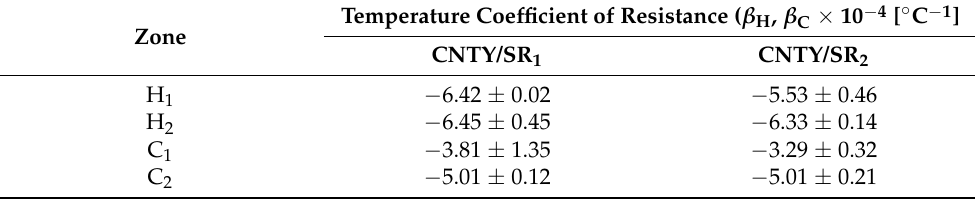
Table 3. Temperature coefficients of resistance extracted during heating–cooling temperature pro- gram.